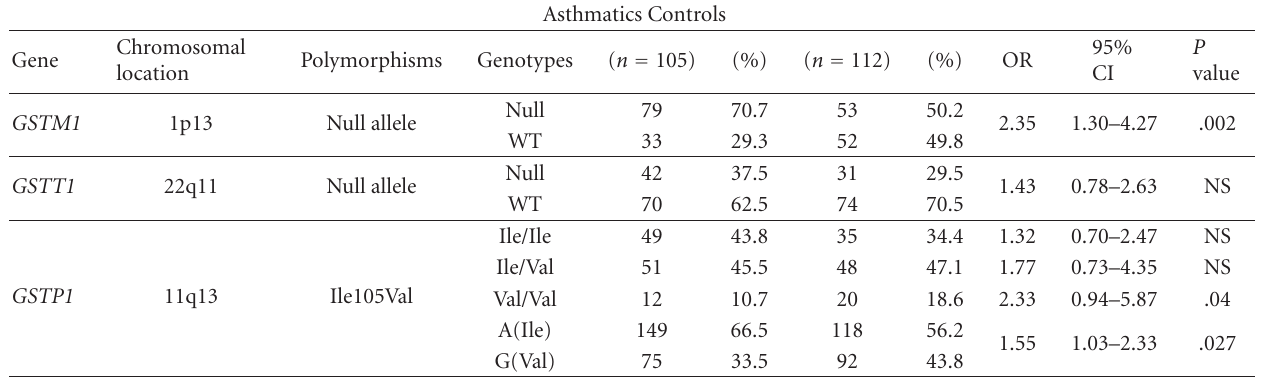
Table 2: Association of genotype profile between asthmatics and controls. NS: P value > . 05.